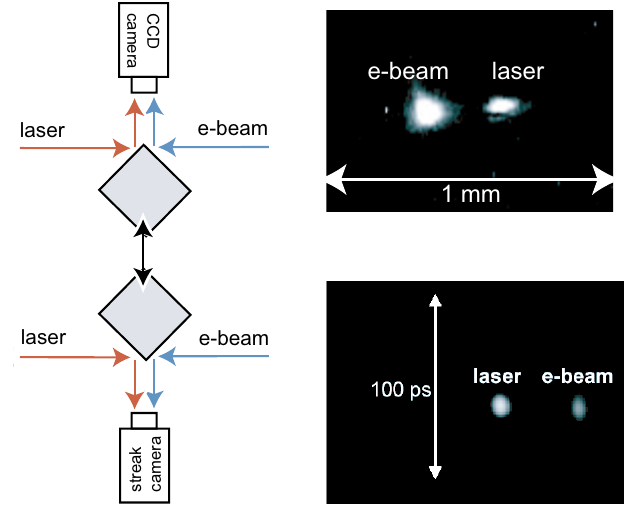
FIG. 29. (Color) Illustration of the interaction point diagnostic. In one position (top) both the laser and OTR light are directed to a CCD video camera. By moving the cube transverse to the beam path (bottom), the light is redirected to a streak